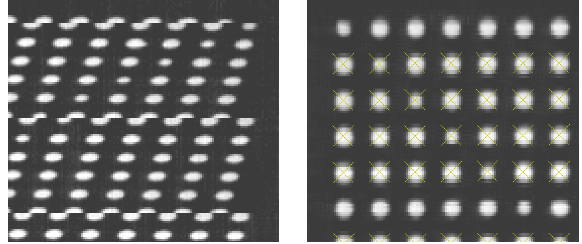
Figure 2. Example of the image formed by Elektro-L in the channel IR4 under imagery of the reference sample (on the left) and result of the geometrical transformation (on the